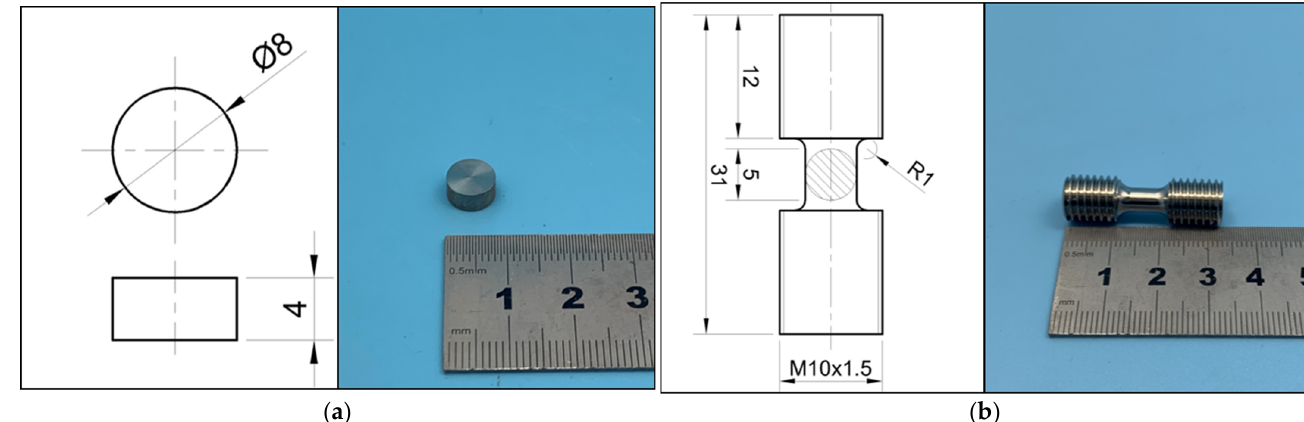
Figure 2. Dimensions of ( a ) compressive specimens and ( b ) tensile specimens. Unit: mm.